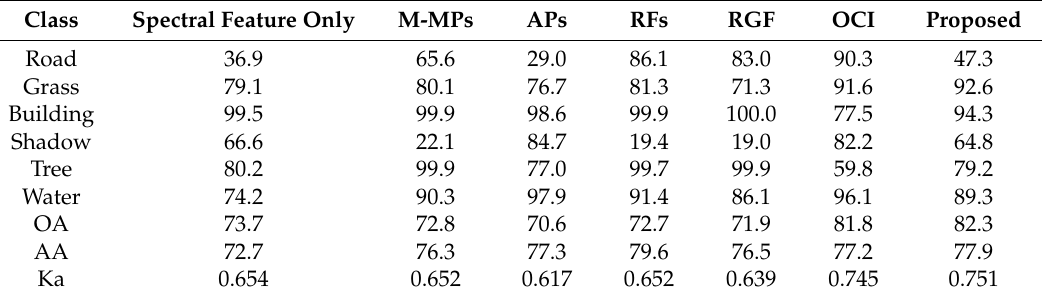
Table 6. Class-specific accuracies (%) for features in SVM classification of aerial image data.